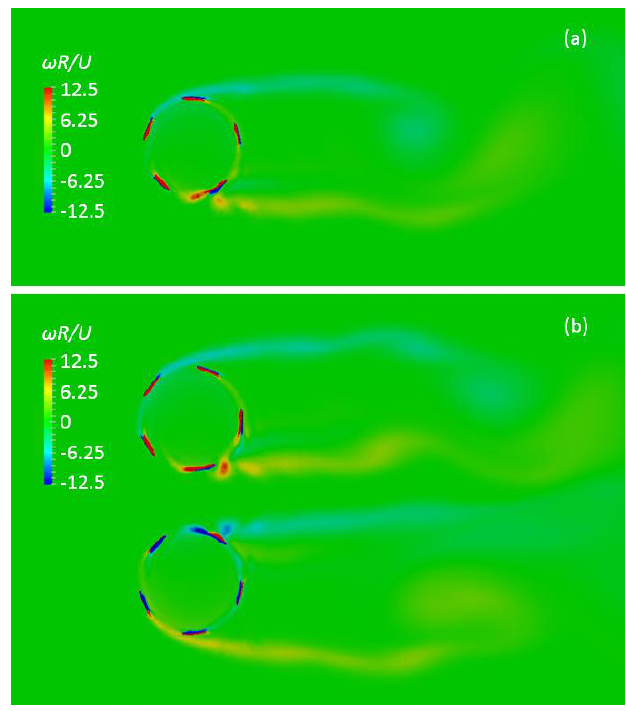
Figure 9. Snapshots of the vorticity fields generated by ( a ) an isolated rotor and ( b ) a pair of rotors. Both are steady-state rotations with ambient velocity U = 10 m/s. The same vorticity contour scale was used.